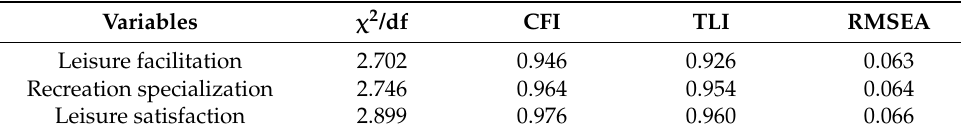
Table 2. CFA Fit Indices.